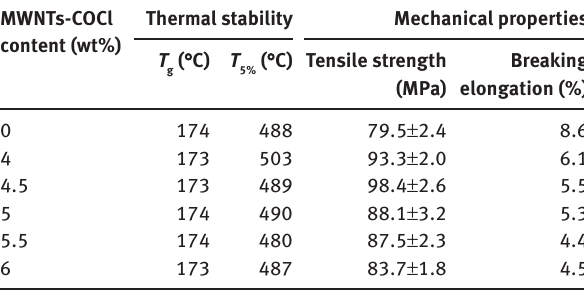
Table 1: Thermal stability and mechanical properties of PEN-MWNT composite